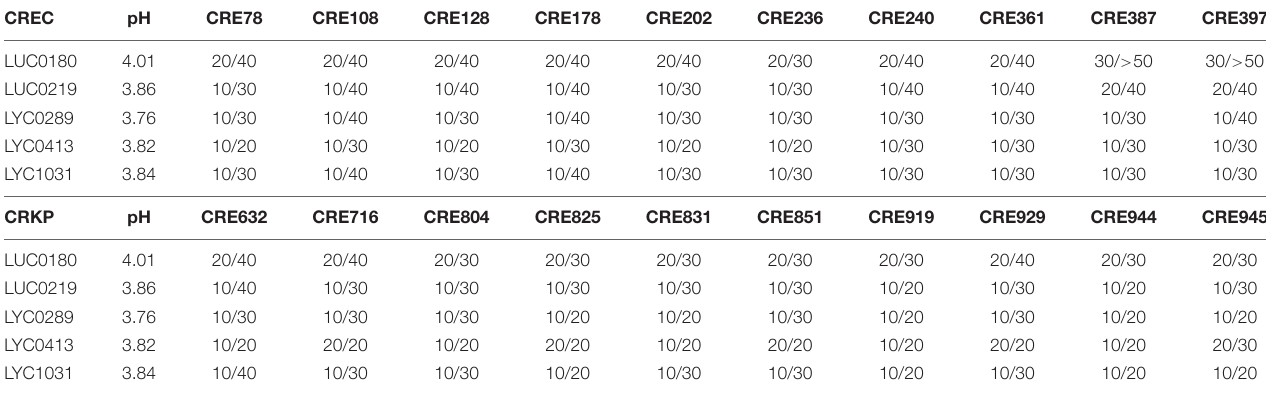
TABLE 5 | The resulting pH and MIPs/MBPs of five Lactobacillus strain supernatants (%) against carbapenem-resistant E. coli (CREC) and K. pneumoniae (CRKP). CREC